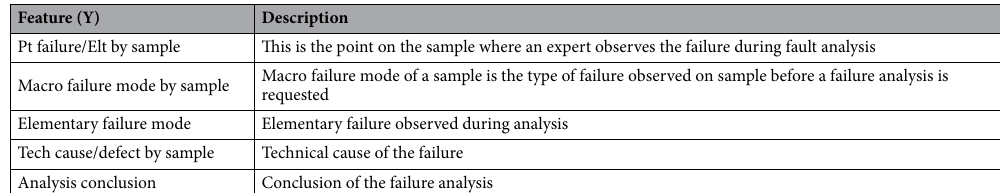
Table 1. Textual features and its description present in the data set of the conclusion of failure analysis Y.